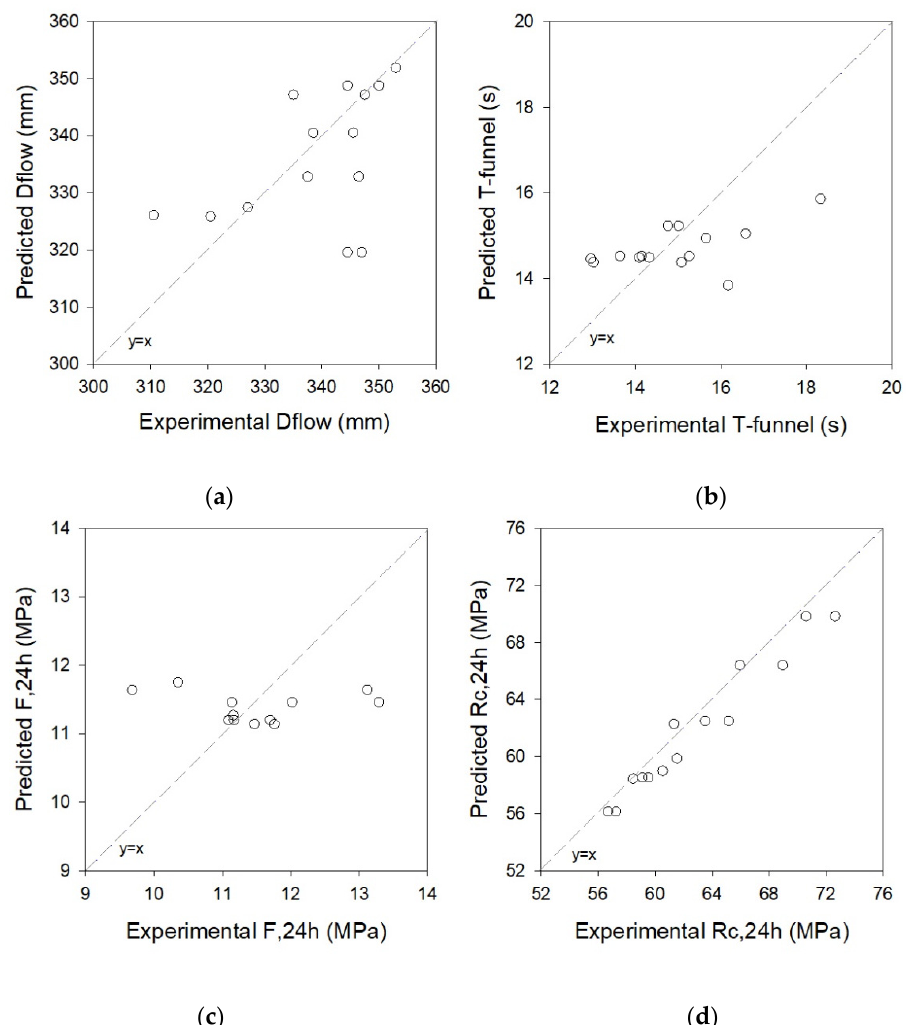
Figure 11. Predicted versus measured: ( a ) D-flow; ( b ) T-funnel; ( c ) F,24 h, and ( d ) Rc,24 h.